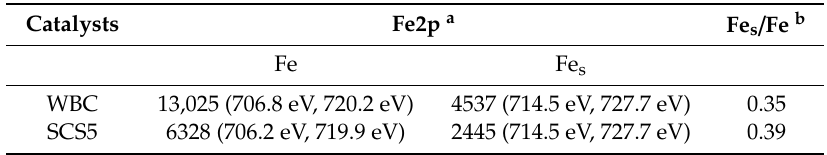
Table 4. The peak area of Fe, Fe in Solid solution and Fe 2 O 3 species by XPS.